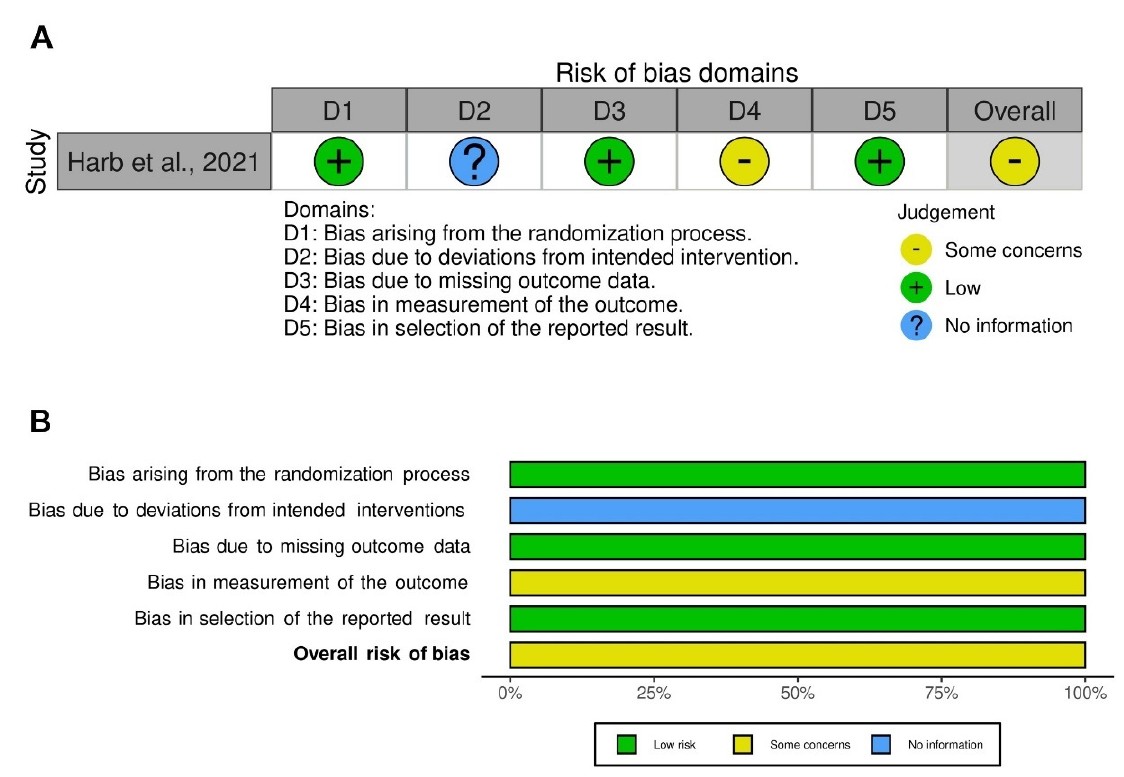
Figure 4. Assessment of the risk of bias via the Cochrane RoB 2 tool displayed by means of a traffic light plot of the risk of bias of the included randomized clinical study ( A ) [31], and weighted plot for the distribution of the overall risk of bias within each bias domain via the Cochrane RoB 2 tool ( B ) ( n = 1 clinical study). Traffic light plot reports five risk of bias domains: D1, bias arising from the randomization process; D2, bias due to deviations from intended intervention; D3, bias due to missing outcome data; D4, bias in measurement of the outcome; D5, bias in selection of the reported result. Yellow circle indicates some concerns on the risk of bias, green circle represents low risk of bias, and blue circle indicates no information. RoB: risk of bias.